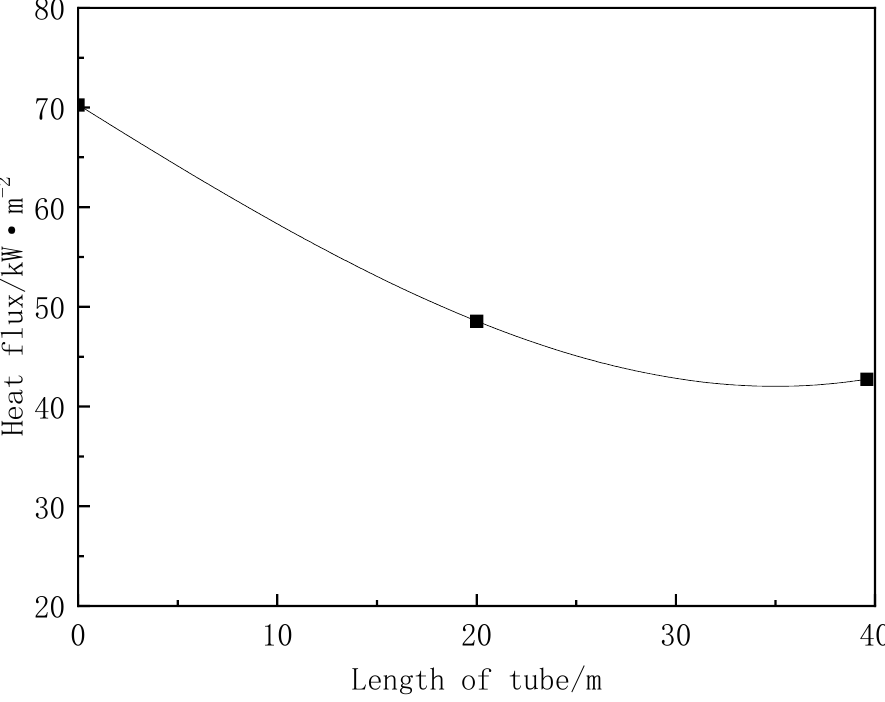
Figure 6. Heat flux of the cooling wall tube.